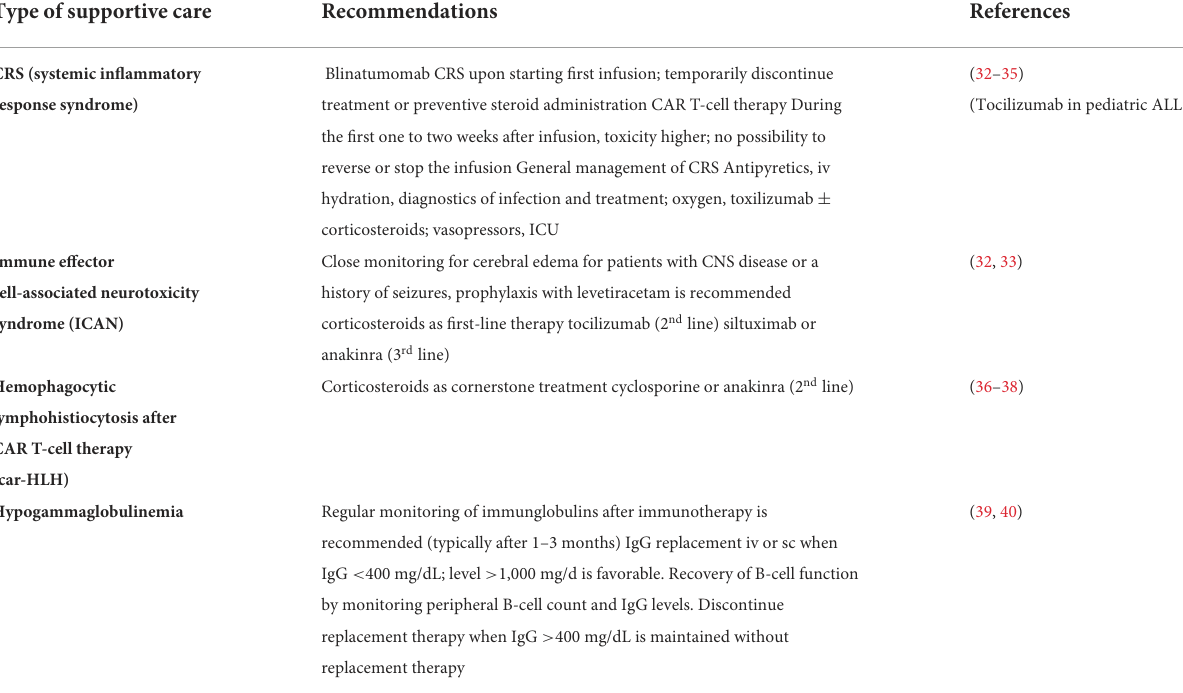
TABLE 2 Compilation of relevant guidelines and recommendations for supportive care in new therapies for childhood